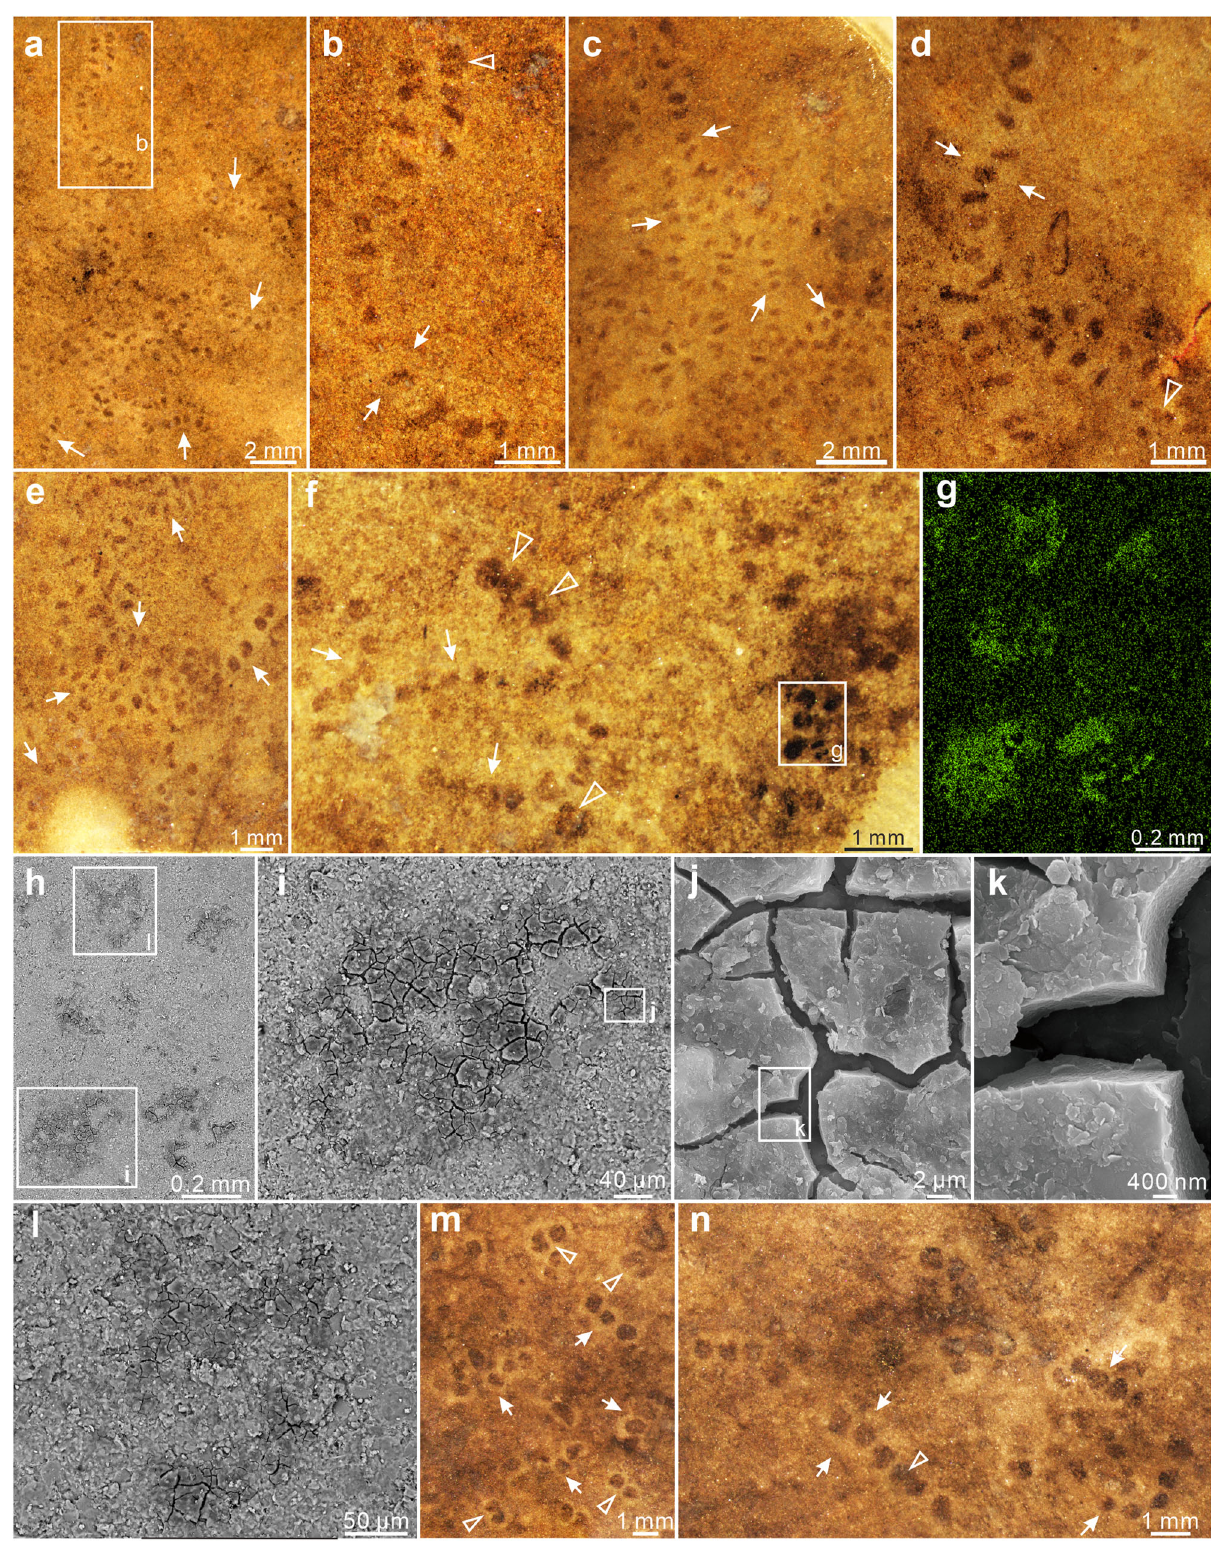
range of the Shiwangzhuang specimens (Fig. 6c). Short strings, each consisting of only two beads, are sometimes found among longer strings (Fig. 5m), but they are similar in the size and shape of beads and halos. In the short strings, beads are between 0.45 mm and 0.66 mm in diameter (average = 0.54 mm; SD = 0.06 mm; n = 18